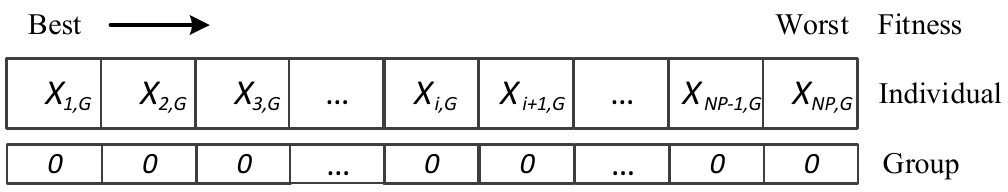
Figure 5. Fitness values of the parameter vectors in descending order.